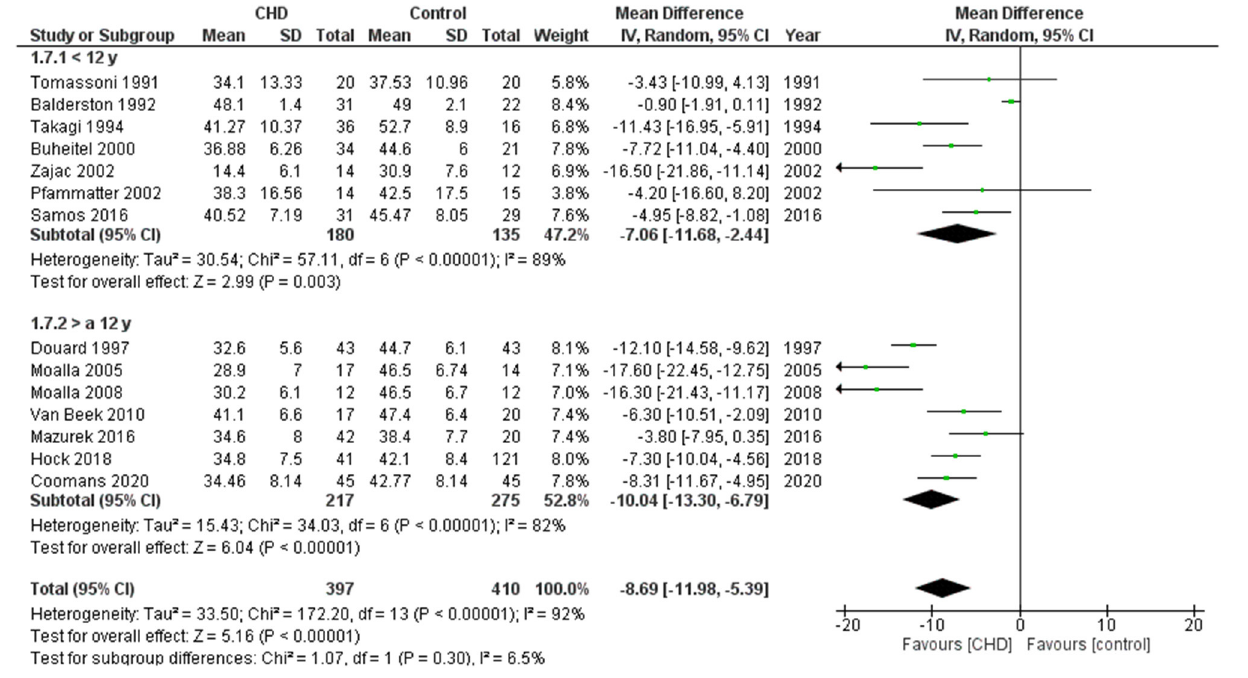
FIGURE 3 | Forest plot for mean peak oxygen consumption for CHD in children and adolescents and healthy controls. Subanalysis by age.